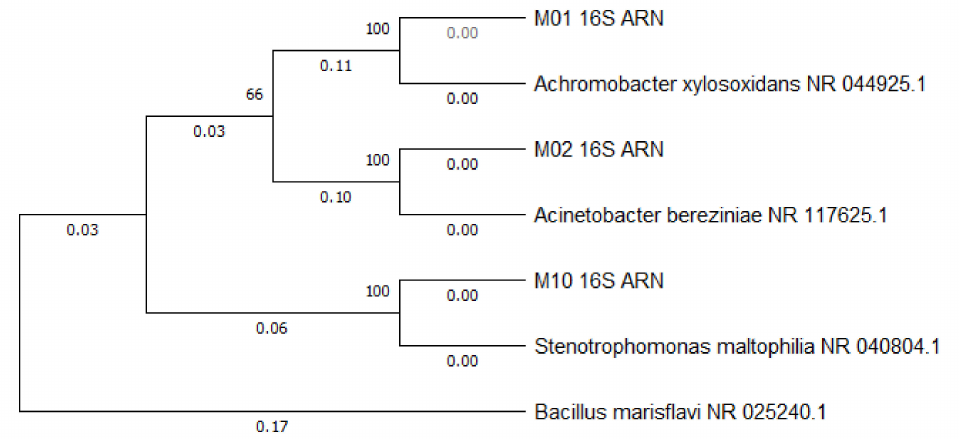
Figure 6. Dendrogram of bacterial groups isolated at the MFC’s anode with papaya juice substrate.